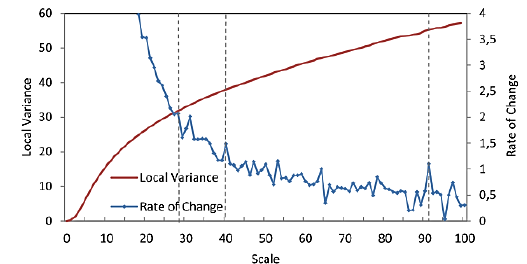
Figure 4. RoC-LV graph of whole image. Fine, moderate and coarse scales values were selected as 28, 40 and 91, respectively.